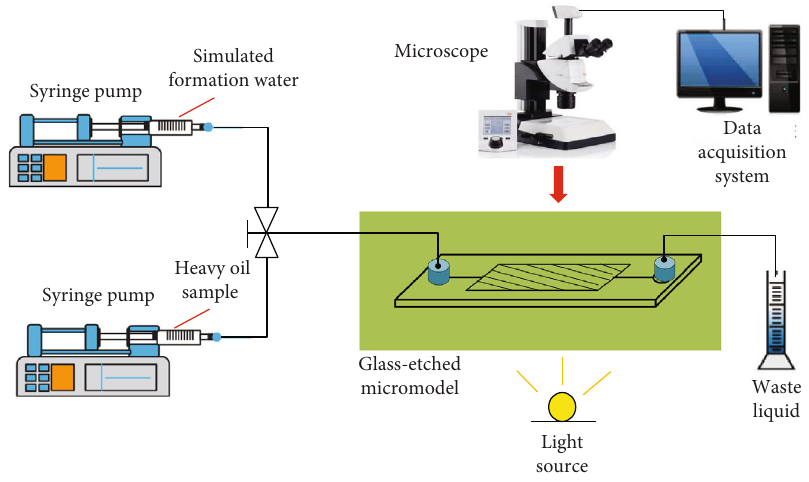
Figure 3: The schematic diagram of micromodel fl ooding experimental apparatus.